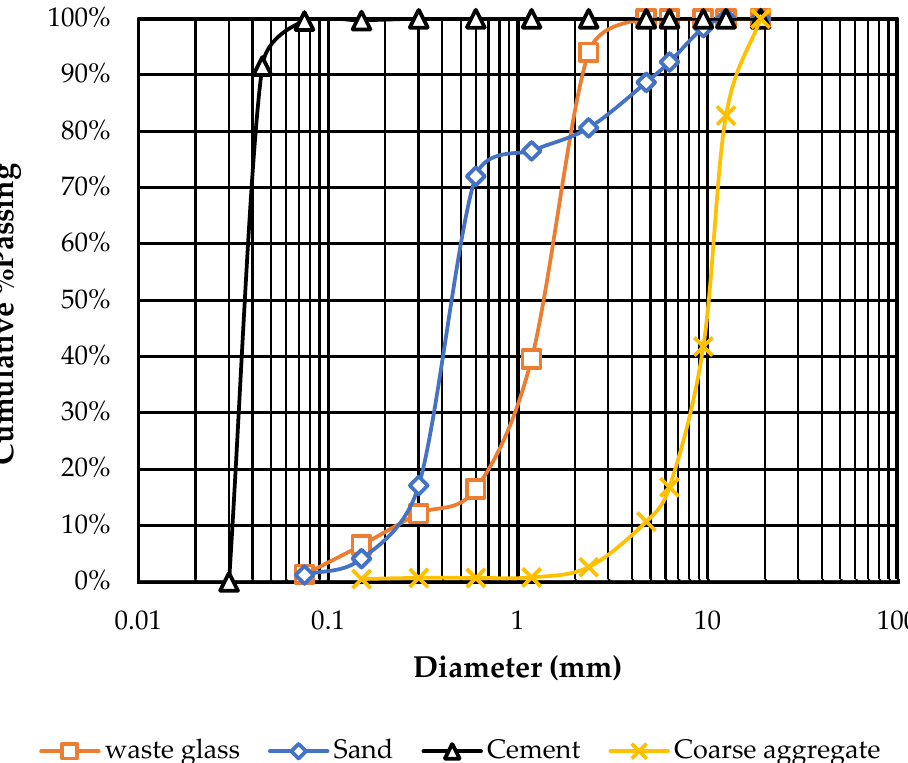
Figure 2. Treated PA fibers with NaOH solution.